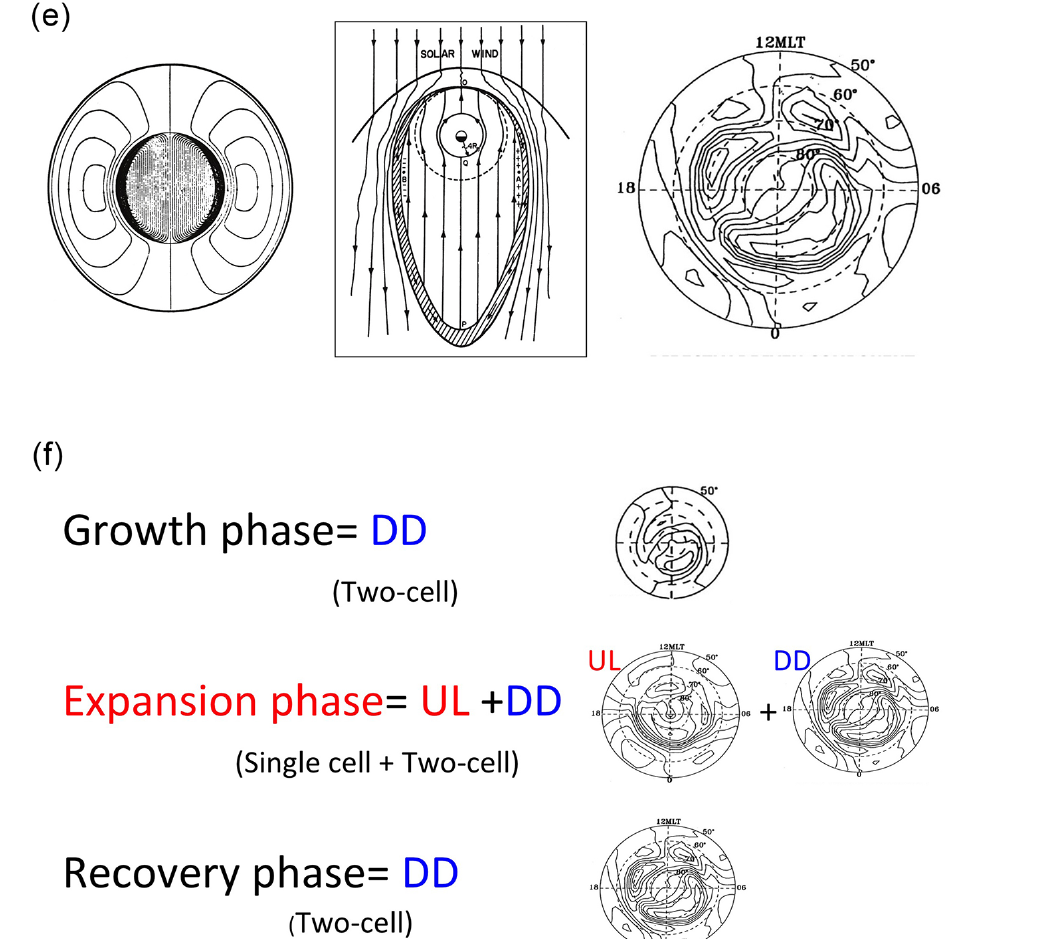
Figure 4. (e) Left: Chapman’s SD current (polar view). Middle: the pattern of magnetospheric convection on the equatorial (Axford and Hines, 1961). Right: the actual convection pattern (Sun et al., 1998). (f) The current system during substorms consists of two components. The two-cell current (directly driven, DD) exists throughout the life of substorms; however, single-cell current occurs only impulsively during the expansion